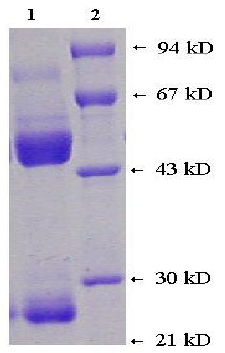
Figure 3. SDS-PAGE (T = 12 %, C = 3) of monoclonal antibody 1F2 after affinity